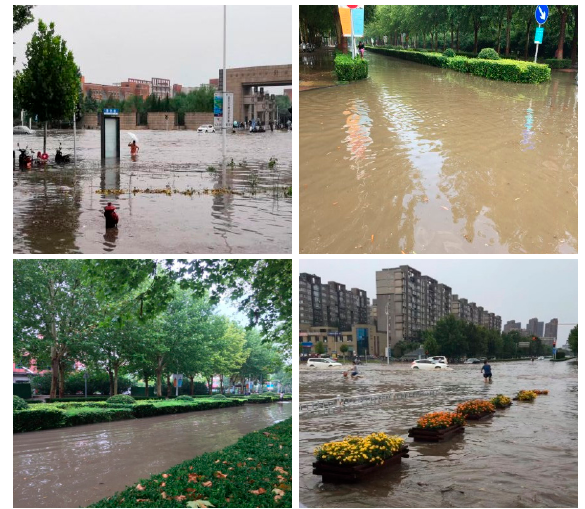
Figure 5. Waterlogging on the campus of Zhengzhou University in recent years.